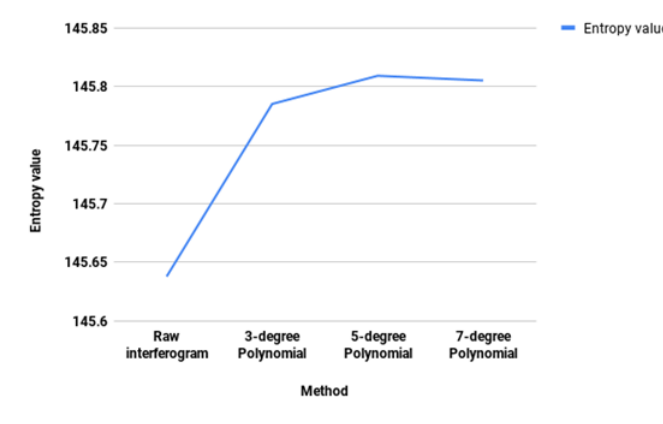
Figure 5: Entropy values of raw interferogram and flattened interferogram using different